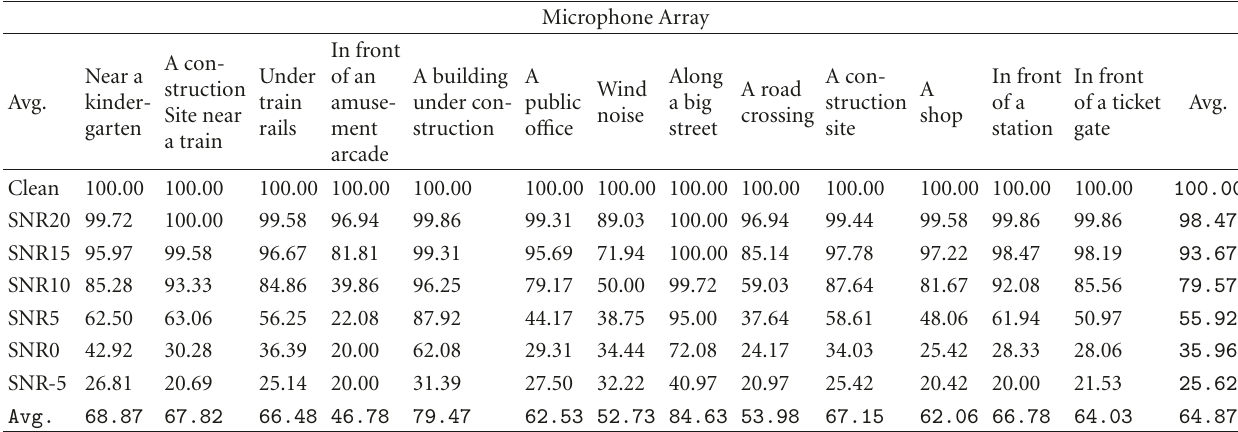
Table 3: Recognition accuracy of the microphone array.